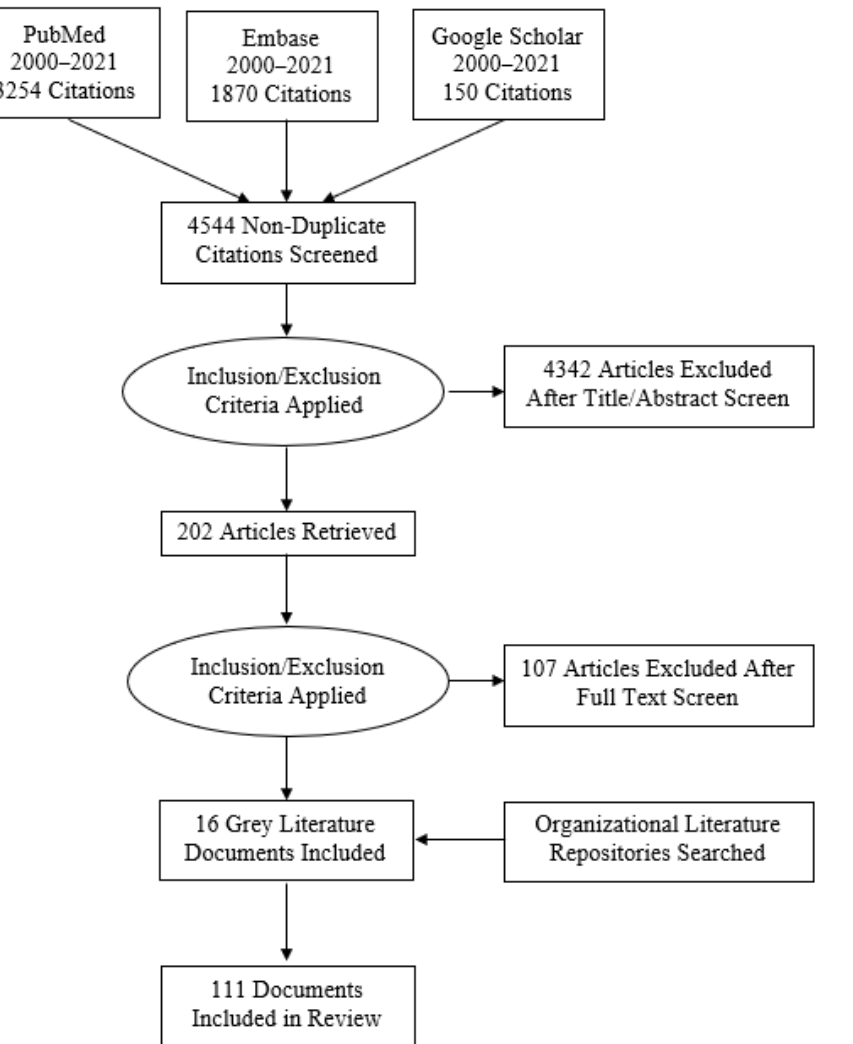
Figure 1. Literature selection diagram. Table 4. AYSRH-friendly assessment tools included in